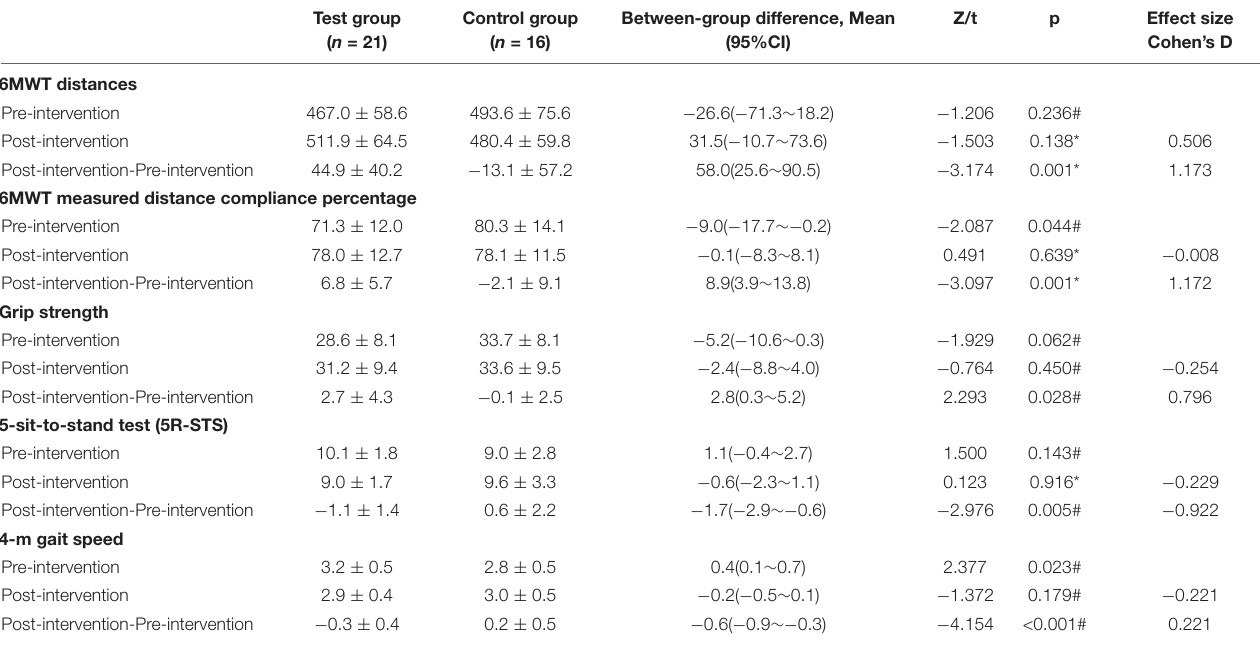
TABLE 2 | Changes in primary